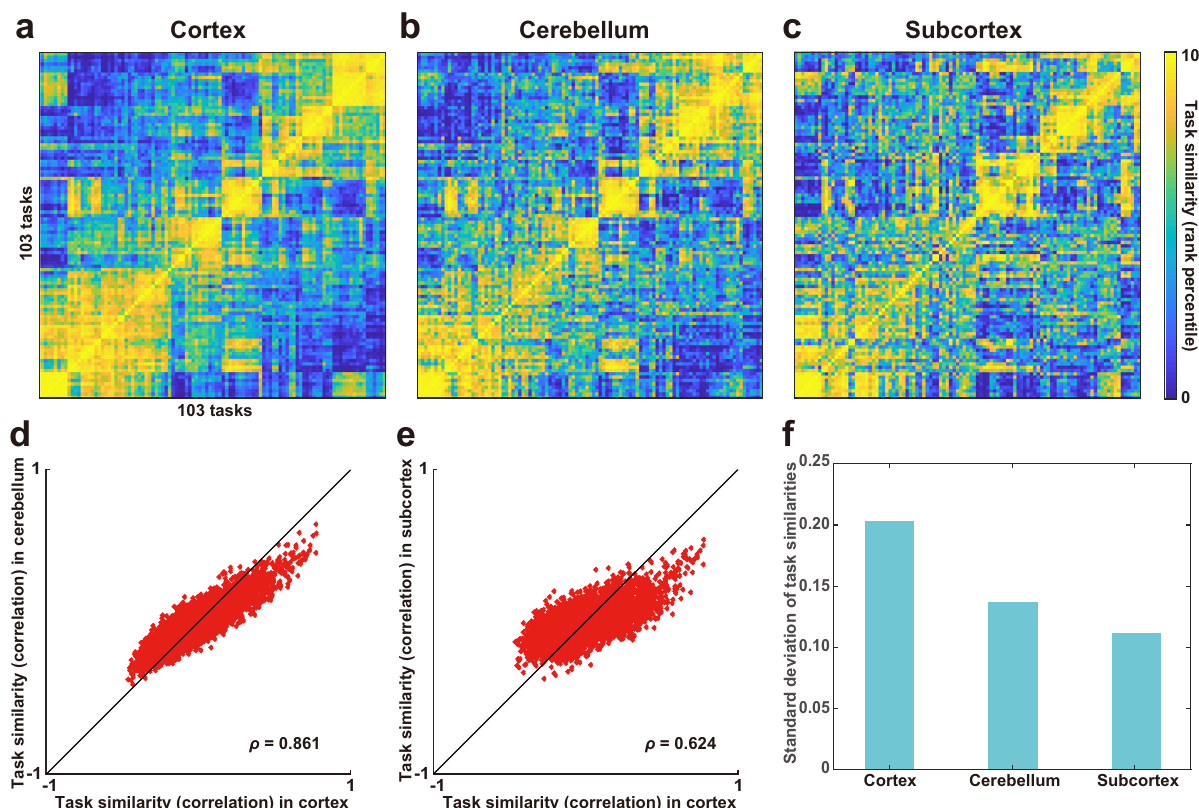
Fig. 2 Similar task representations across the cortex, cerebellum, and subcortex. a – c The representational similarity matrix (RSM) was constructed based on task similarity (Pearson ’ s correlation coef fi cient) between each task pairs for the a cortex, b cerebellum, and c subcortex. Task similarity was calculated using weight vectors of all voxels included in the target region, concatenated across six subjects. A total of 103 tasks were ordered based on hierarchical clustering analysis for the cortical data. Task similarity was transformed to the rank percentile for the purpose of visualization. Task similarities were plotted d for the cortex and cerebellum, and e for the cortex and subcortex ( n = 5,253). f Standard deviation of task similarities across the cortex, cerebellum, and